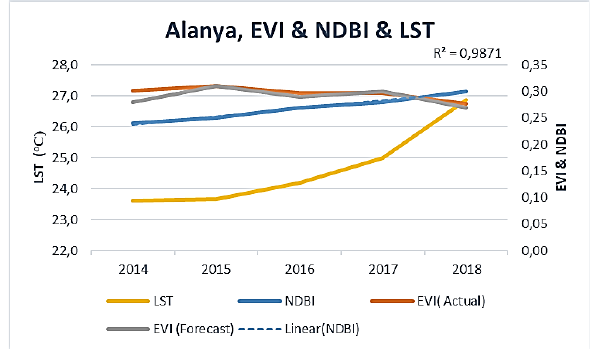
Figure 7. Line plot of the mean annual value for the years 2014-2018 (alpha =